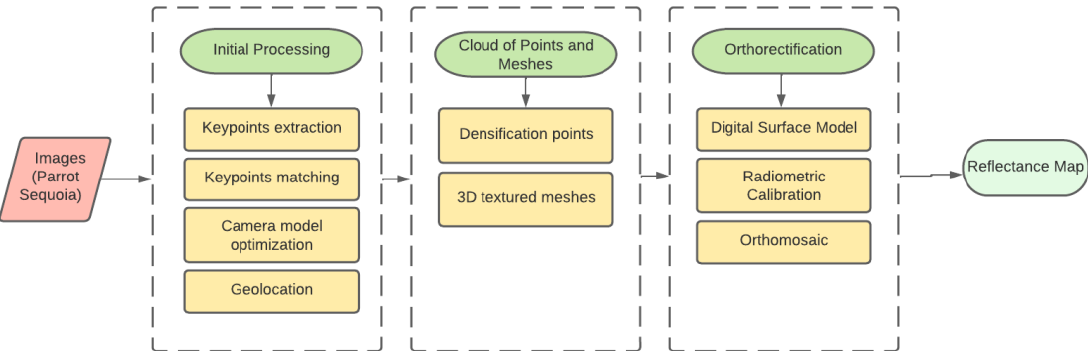
Figure 3. Image processing flow in Pix4D Mapper software.